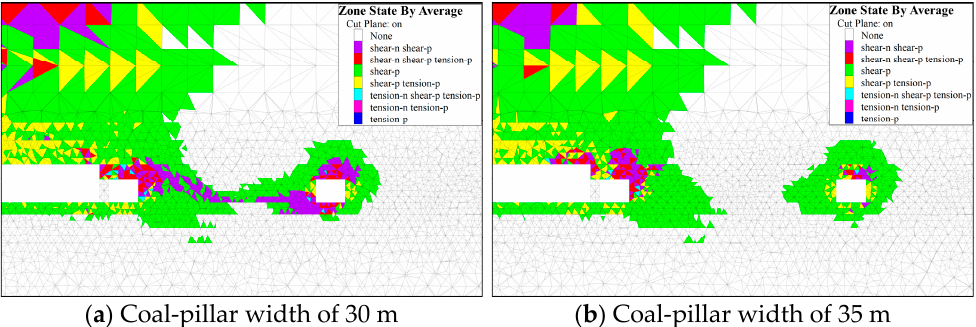
Figure 7. Lines of lateral stress distribution.